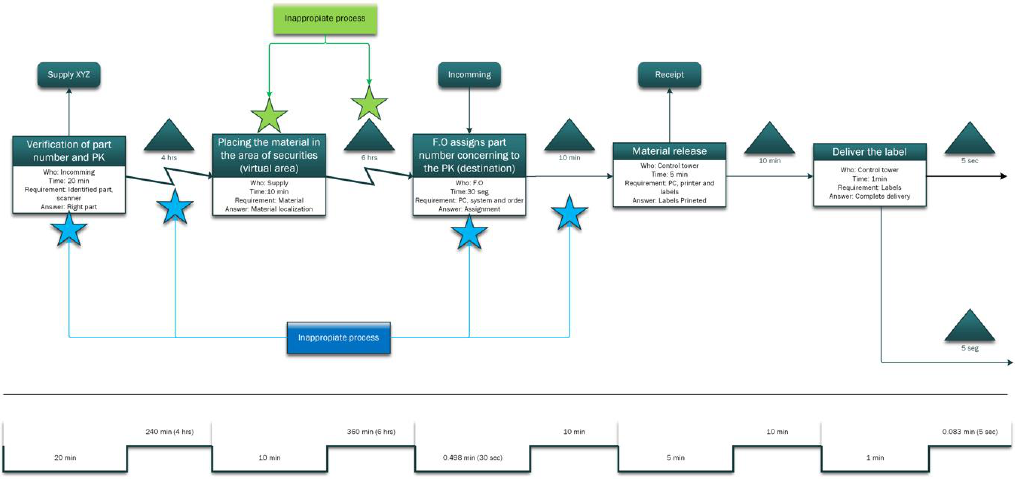
Figure 12. The third part of seven of the Current State Value Stream Map with wastes.